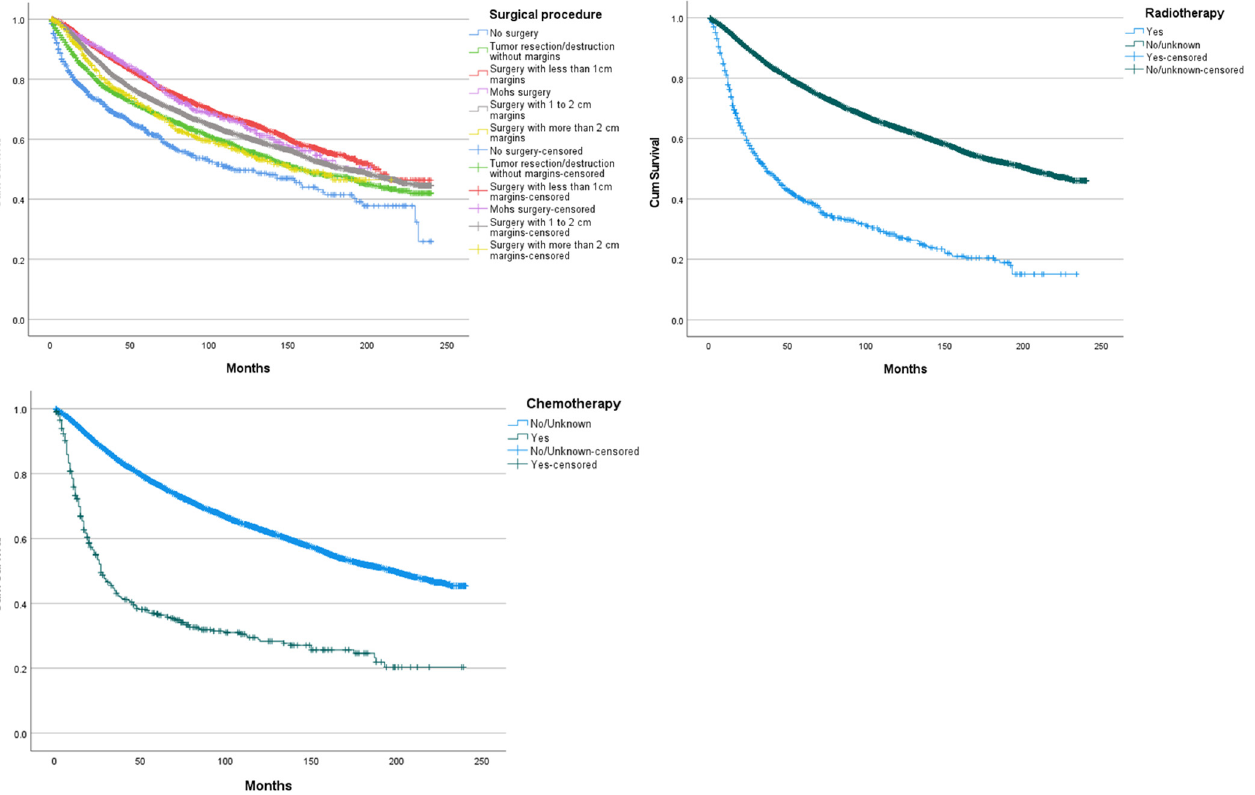
Figure 3. Overall survival curves, according to surgical procedure, radiotherapy, and chemotherapy.